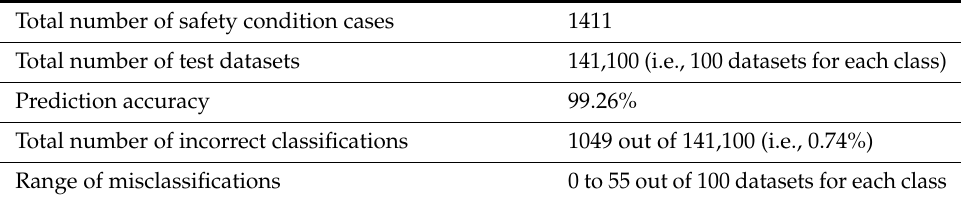
Table 5. Summary of misclassifications for different cases.